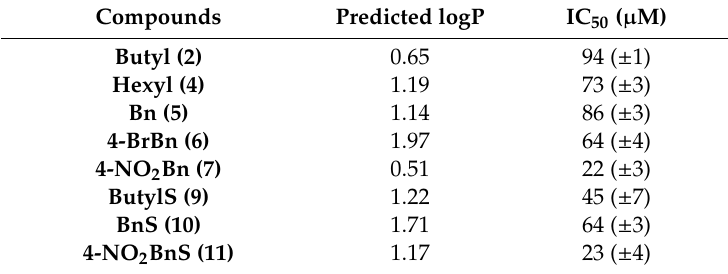
Table 1. Predicted logP and IC 50 values for compounds 2 , 4 – 7, and 9 – 11 . IC 50 values were estimated with an increasing concentration of each compound in competition with 200 nM of OHHL.